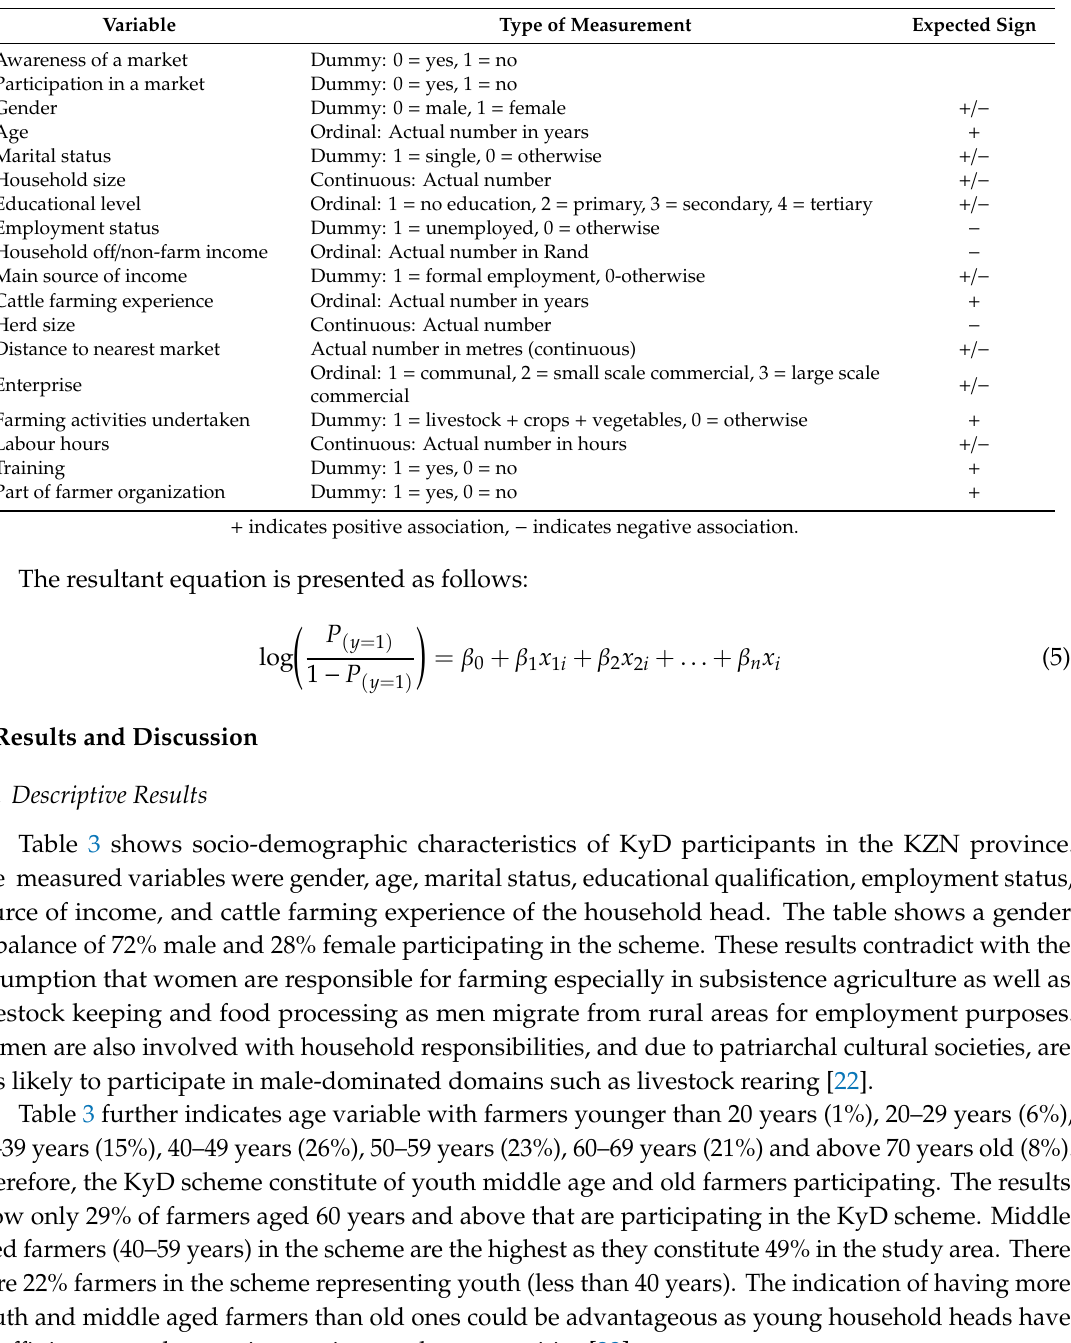
Table 2. Variables used in the logit